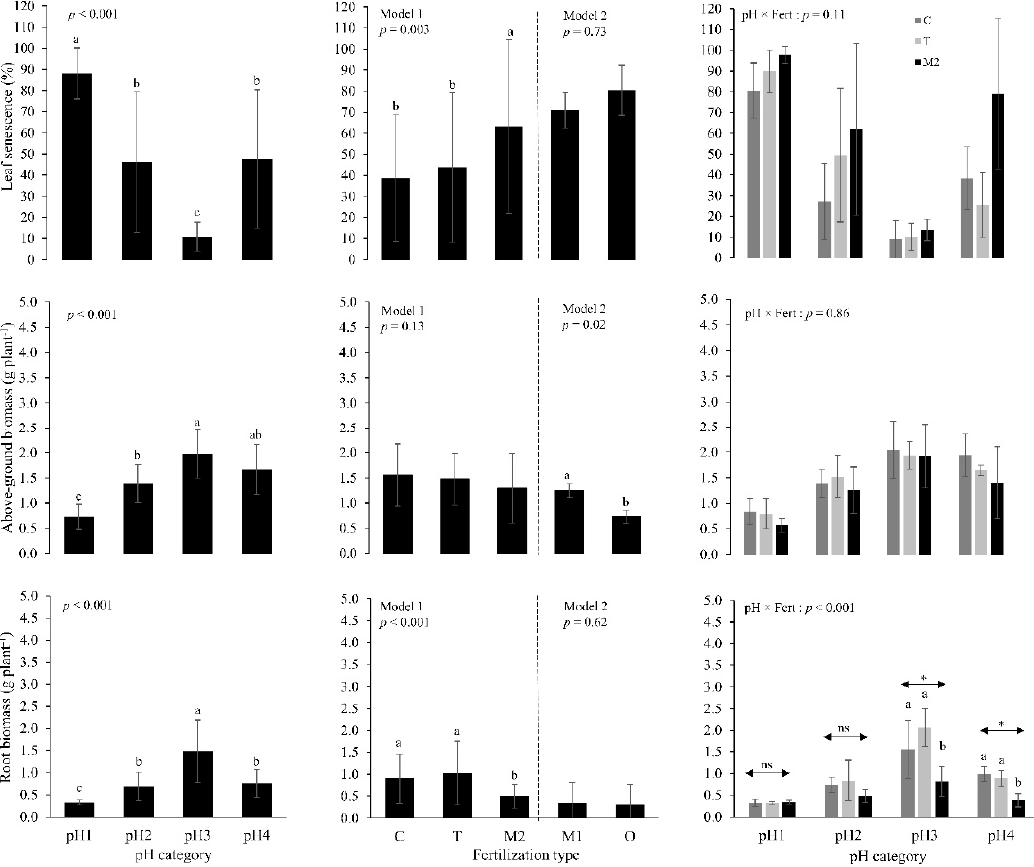
Figure 1. Leaf senescence, above-ground and root dry biomass at harvesting, after 19 weeks of vegetative growth in a greenhouse, for treatments with differing soil pH levels and types of fertilizer applied. Error bars represent the standard deviation from the mean. Letters indicate significant differences between the combined averages (main effect figures) and average (interaction figures) based on Tukey’s post-hoc tests. pH1 = strongly acidic; pH2 = moderately acidic; pH3 = slightly acidic; pH4 = neutral (see Table 2 for the pH ranges of each category); C = without fertilizer; T = P + K (without N); M1 = N + P + K, N as ammonium sulfate; M2 = N + P + K, N as calcium nitrate; O = N + P + K, as organic fertilizer (granulated poultry manure).